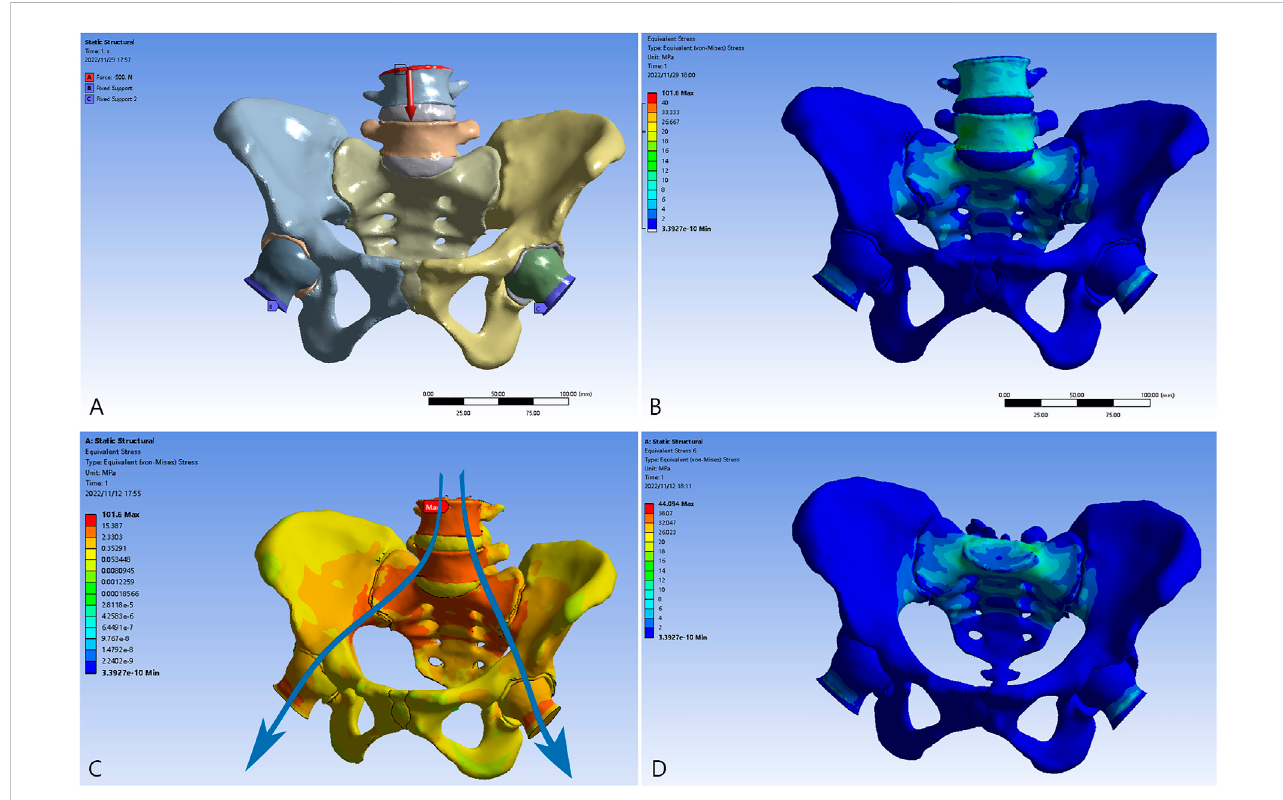
FIGURE 3 The validation model of the normal pelvis. (A) The bilateral proximal femurs were restrained, and the load was applied to the L4 vertebra. (B) The distribution of the von Mises force. (C) The transmission of loading stress from the trunk (blue arrows). (D) The distribution of the force in the pelvic